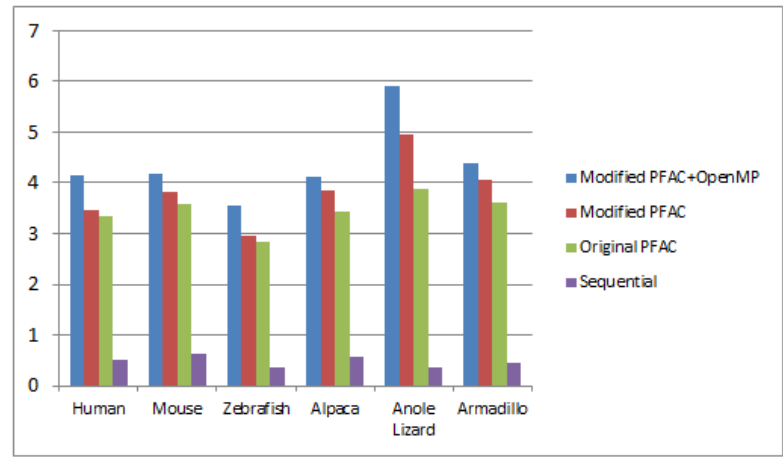
Figure 9: System throughput (Gbps). Table 1: Execution time for each implementation (DB1: Human (26.635MB), DB2: Mouse (28.057MB), DB3: ZebraFish (22.59MB), DB4: Alpaca (28.914MB), DB5: Anole Lizard (59.714MB), DB6: Armadillo